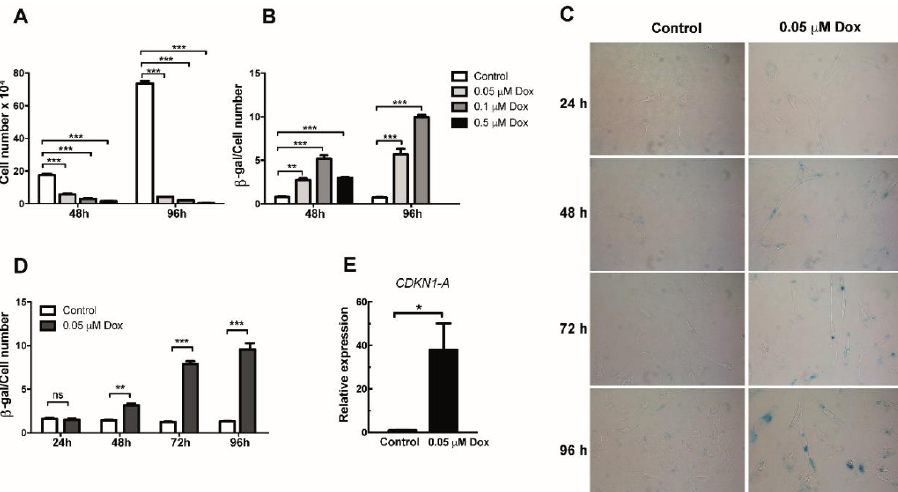
Figure 1. Analysis of proliferation and senescence in doxorubicin-treated HMEC-1 cells. ( A ) Number of HMEC-1 cells treated with three different concentrations of doxorubicin for 48 and 96 h. ( B ) Senescence-associated (SA)-β Galactosidase (SA-β-Gal) activity in doxorubicin (Dox)- and vehicle-treated (control) HMEC-1. Quantification was based on color intensity corrected by the number of cells. ( C ) Representative images of SA-β-Gal staining in HMEC-1 cells following treatment with 0.05 μM of doxorubicin for 24, 48, 72 and 96 h. ( D ) Quantification of SA-β-Gal activity in HMEC-1 cell treated with 0.05 μM of doxorubicin for 24, 48, 72 and 96 h. ( E ) Expression analysis of CDKN1 (encoding p21 CIP1/KIP1 ) RNA levels in cells treated with 0.05 μM of doxorubicin. Error bars indicate mean ± SD of n = 3 (NS = no significant; * p < 0.05; ** p < 0.01; *** p < 0.001; t -student test).